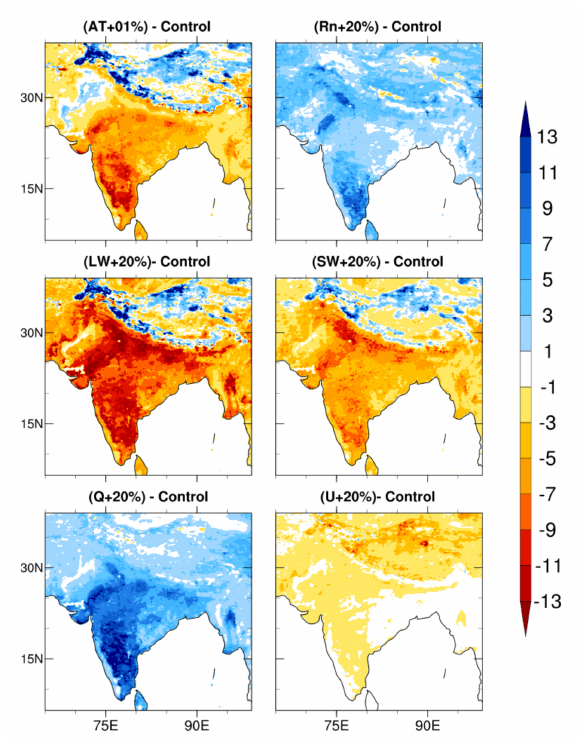
Figure 6. Soil moisture change (%) during OND in each positive sensitive experiment compared to the control experiment during the year